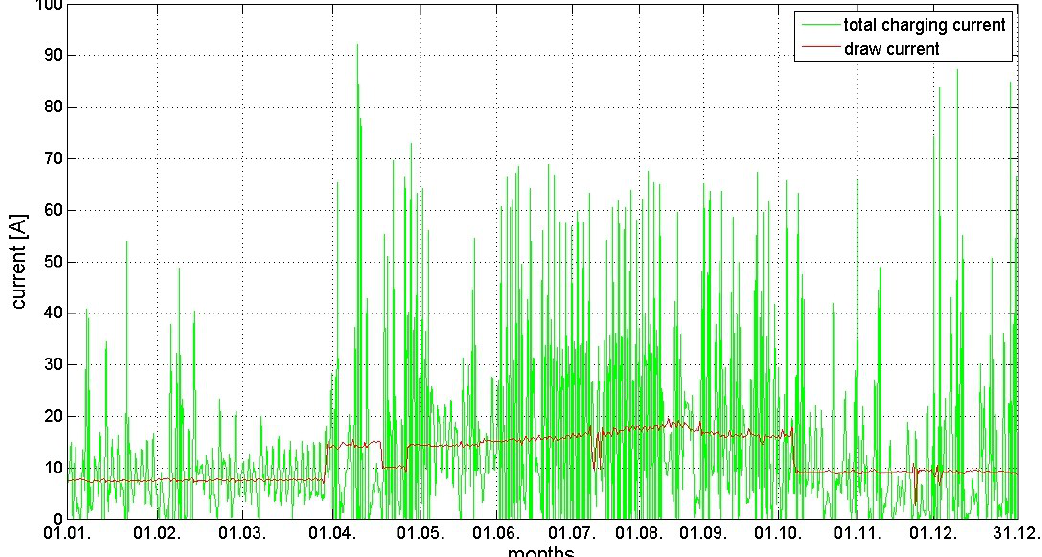
Figure 5. Interdependence of total charging and discharging currents for the BSS A during one year.